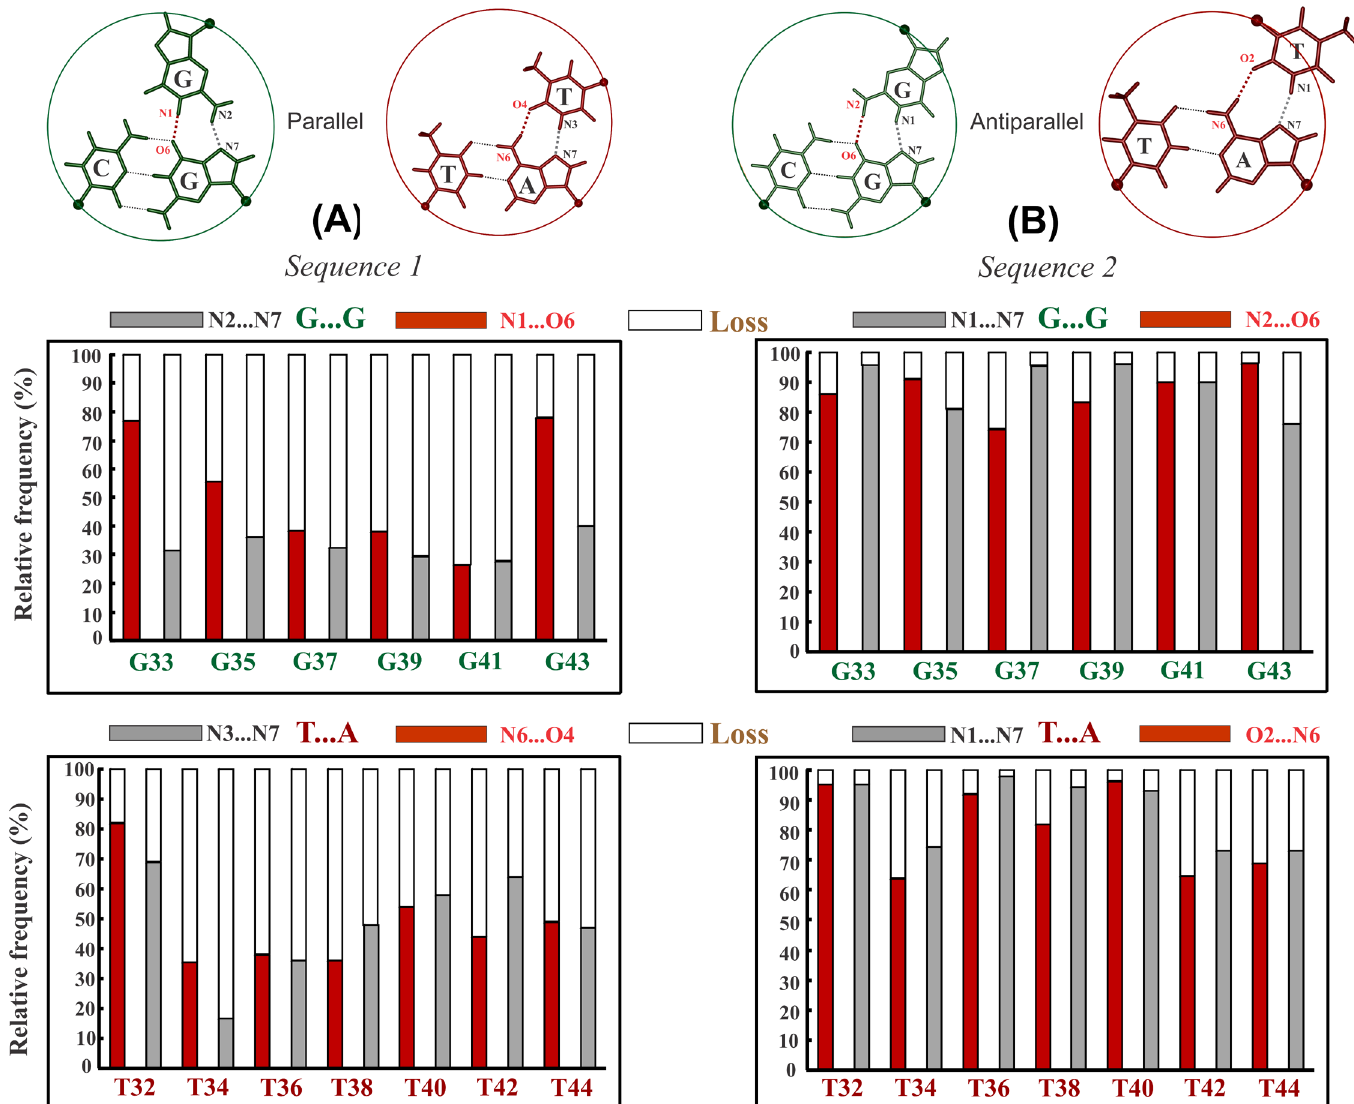
Fig 2. Demonstration of unstable and stable nature of parallel and antiparallel triplex formed by alternating G * GC & T * AT triplets respectively. A Frequency of incidence (red & gray filled part) and loss (void part) of canonical (A) Hoogsteen (Sequence 1) and (B) reverse Hoogsteen hydrogen bonds (Sequence 2) in the central 6 G * GC and 7 T * AT triplets of the 15-mer parallel and antiparallel triplex (terminal triplets not considered) over a simulation time of 250 and 100 ns respectively. Wide spread loss of Hoogsteen hydrogen bonds in the (A) parallel triplex (Sequence 1), and retention of reverse Hoogsteen hydrogen bonds in the (B) antiparallel triplex (Sequence 2) are apparent. Canonical Hoogsteen and reverse Hoogsteen hydrogen bonding schemes in the G * GC & T * AT base triplets in parallel & antiparallel orientations are shown on top for